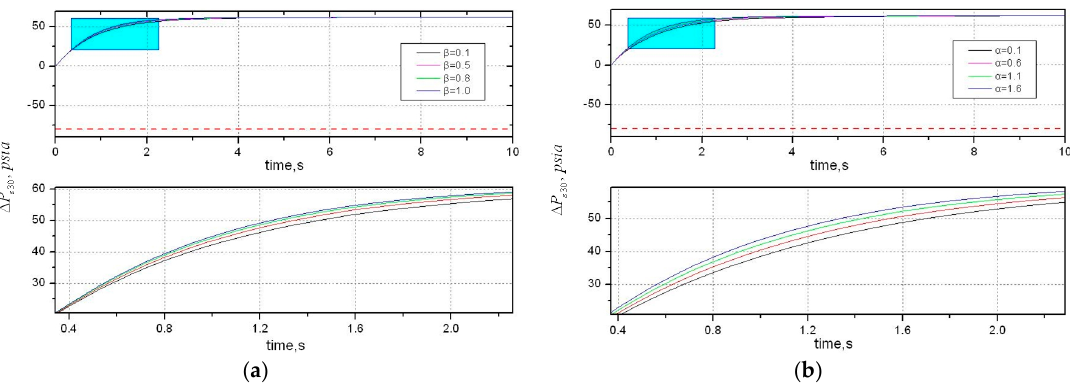
Figure 8. High-pressure compressor outlet static pressure response with uncertainty in system parameters. ( a ) Case 1; and ( b ) case 2.